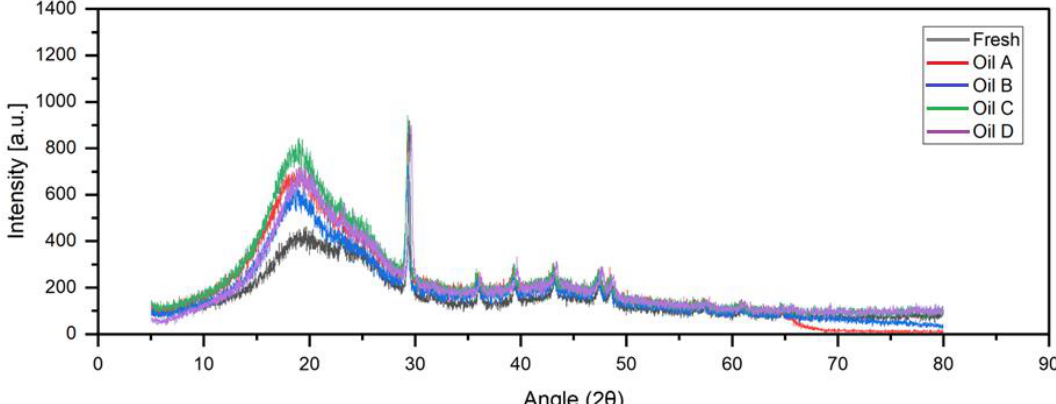
Figure 6. XRD spectra expressed in arbitrary units (a.u.) for the EPDM (fresh and after 168 h of aging).